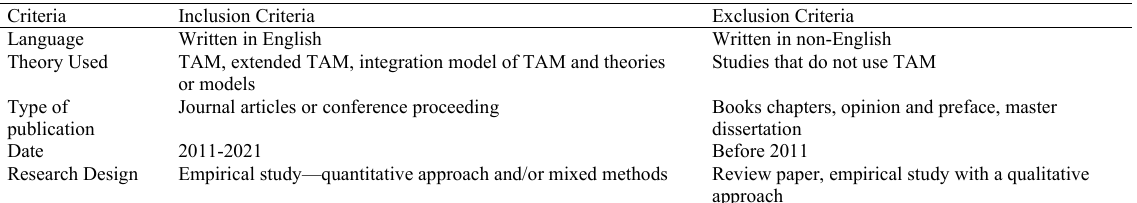
TABLE 1 I NCLUSION AND E XCLUSION C